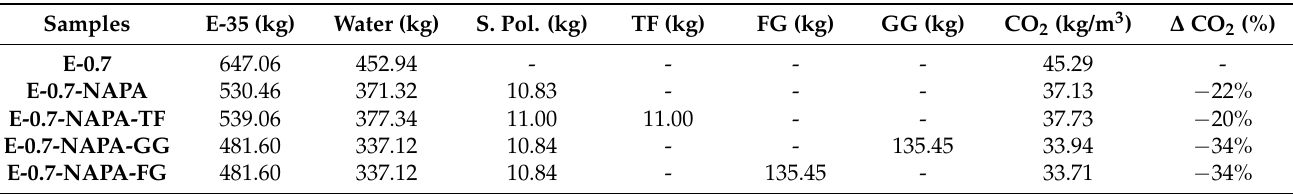
Table 11. Global warming potential